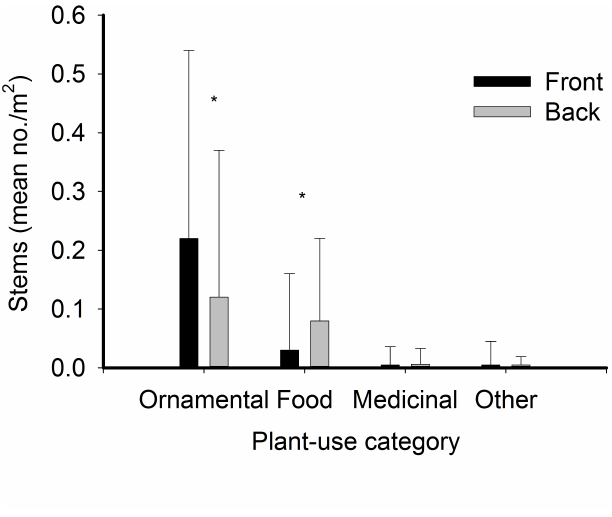
Fig. 9 . Paired t-tests evaluating differences between front yards and backyards in plant species richness, by utilitarian role. Error bars represent standard errors around the mean and (*) indicate significant tests at p values <